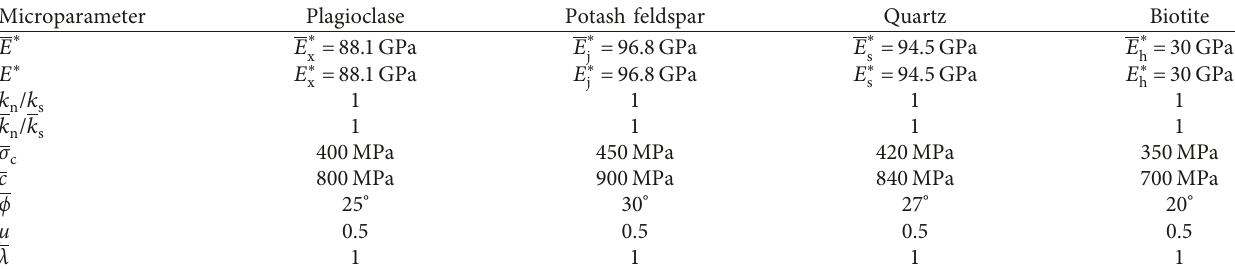
Table 3: Initial values of the